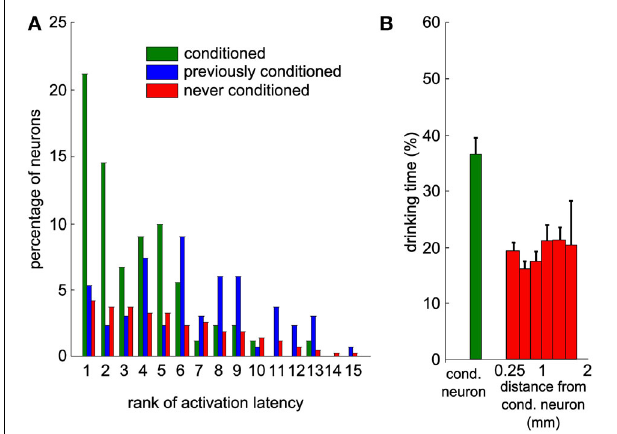
FIGURE 7 | Neighboring neurons recorded simultaneously display delayed modulations of activity that would have led to a lower task performance. (A) Distribution of the ranks of activation for all sessions and all neurons, based on the latencies of increase in firing rate above baseline. This includes only the sessions where this latency could be measured for at least one neuron. All the neurons are partitioned into three categories (green: conditioned during that session; blue: previously conditioned; red: never conditioned; overall, 1993 values from 155 neurons and 88 sessions). (B) Percentage of time during which the bottle was in the drinking zone, using the activity of each of the recorded neurons during trials as an input to the control algorithm to simulate bottle trajectories. The first bin contains all conditioned neurons, while other bins contain all other neurons grouped by distance to the conditioned neuron. Thresholds on the firing rate histograms for the control algorithm were set to the same percentiles than during the real experiment for the conditioned neuron. Vertical bars represent